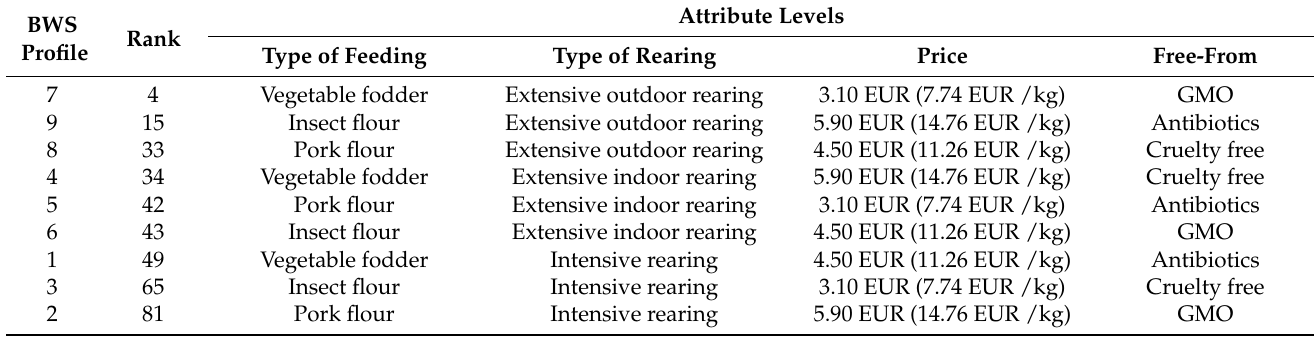
Table 5. Ranking of the BWS profiles included in the survey given the conditional logit model